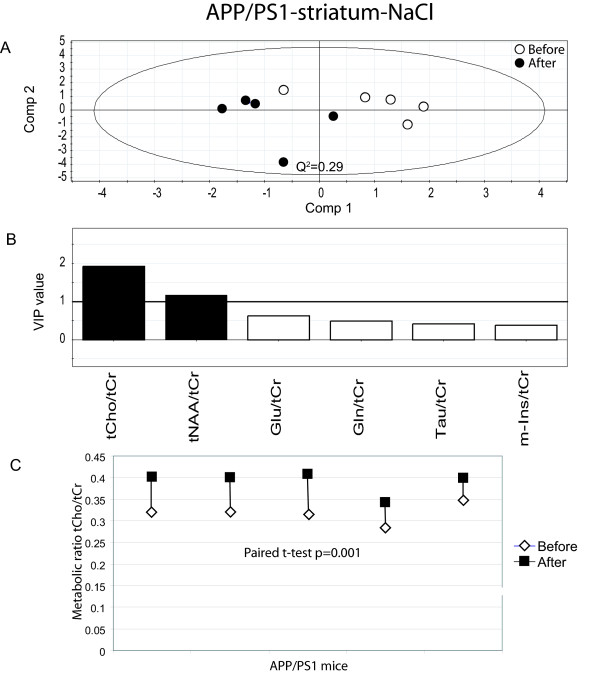
Result from the data analysis of saline treated APP/PS1 (striatum). (A) PLS-DA scatter plot which displays a clear separation between mice before and after saline treatment (white circles = before treatment and black circles after treatment). Each data point represents one mouse. A Q2-value above 0.05 indicates that the groups can be significantly distinguished along that component. (B) Metabolites which are important for the separation between groups in the PLS-DA model. VIP (variable of importance in the projection) values larger than 1 are relevant in explaining group differences (black bars) while metabolites with values below 1 have no significant impact (white bars). (C) The paired t-test shows a significant increase in tCho, p = 0.001. White diamonds represent before treatment and black squares after treatment.